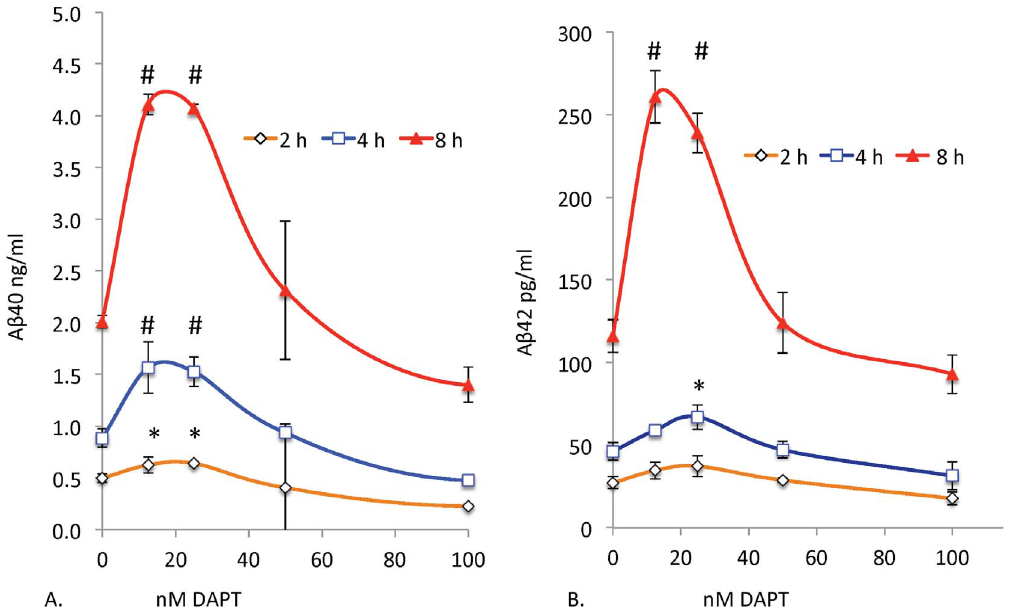
Figure 2. Low doses of DAPT unexpectedly increase A b 40 and A b 42 levels. SH-SY5Y-APP cells were cultured in six-well dishes and treated with either vehicle (DMSO) or DAPT at 12.5 to 1000 nM for 2 (orange), 4 (blue) and 8 h (red). Media were analyzed by sensitive and specific sandwich ELISA assays that use end-specific antibodies to specifically capture the A b 40 (A) and A b 42 (B) and were detected using the end-specific antibodies for the A b N-terminus (3D6, Innogenetics). After Tukey-Kramer adjustment the P values for left panel (A) showed highly significant stimulation of A b 40 at 12.5 and 25 nM (p , 0.0001) at 8 h and significant stimulation at 2 and 4 h. A similar stimulation was also observed for A b 42 at 12.5 and 25 nM (p , 0.0002). Inhibition at a dose of 1 m M was highly significant (p , 0.0001) for A b 40 and 42 as expected (Data not shown). For all graphs significance indicated by symbols # p , 0.01 and * p , 0.05.